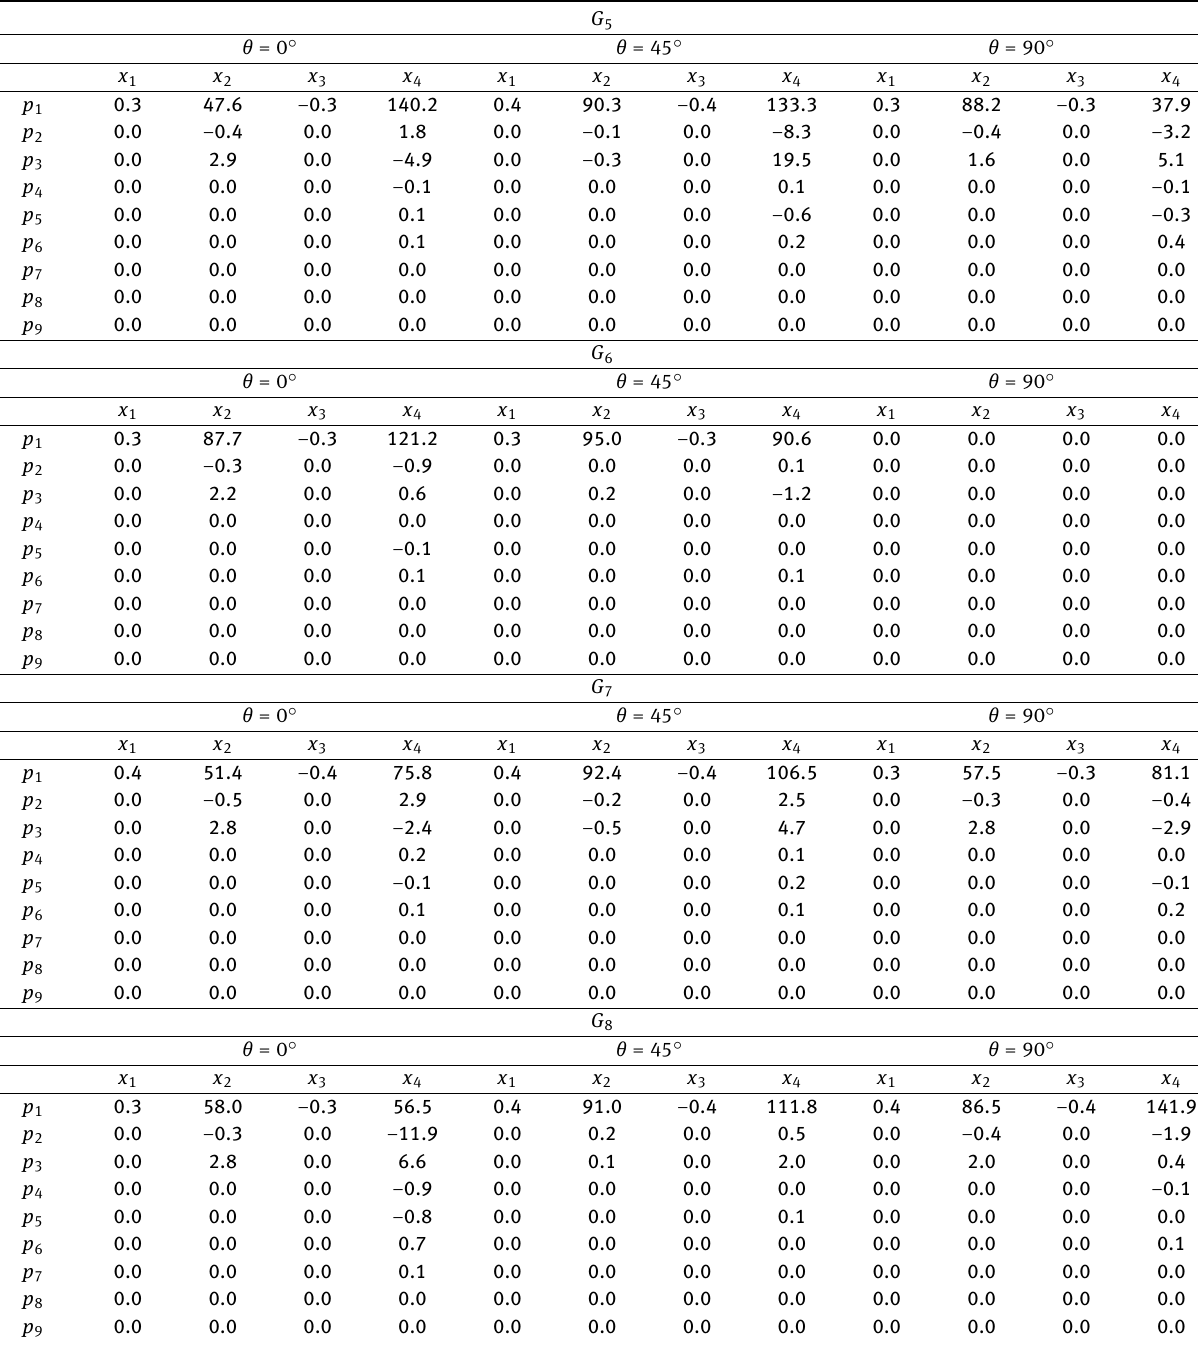
Table A5: Polynomial surface fitting coeflcients ( i.e. , · 10 −3 ) for rectangular plan